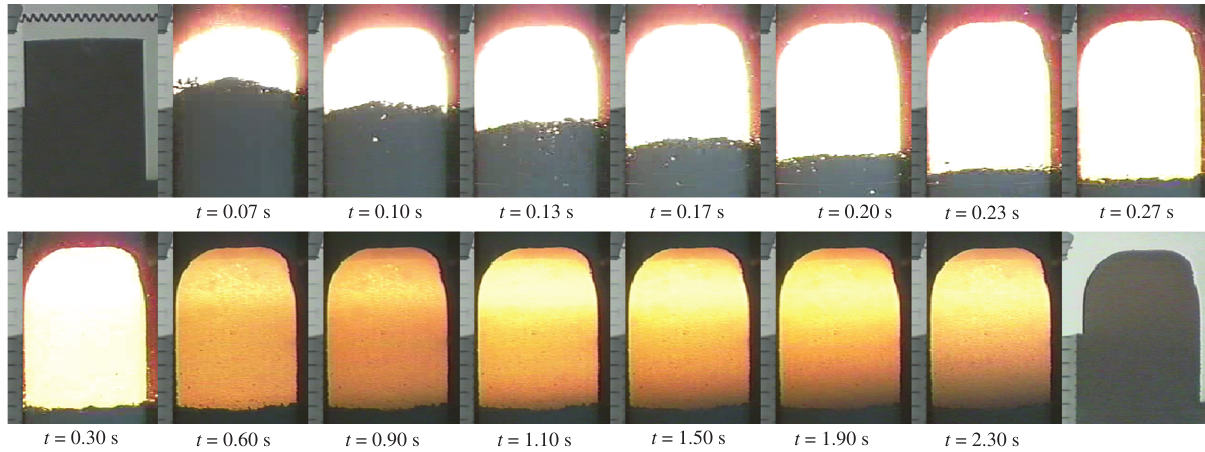
Figure 1: Recorded images illustrating propagation of self-sustaining combustion along an elemental powder compact with Ti:Si ¼ 5:3 and a compaction density of 52.5% TMD.